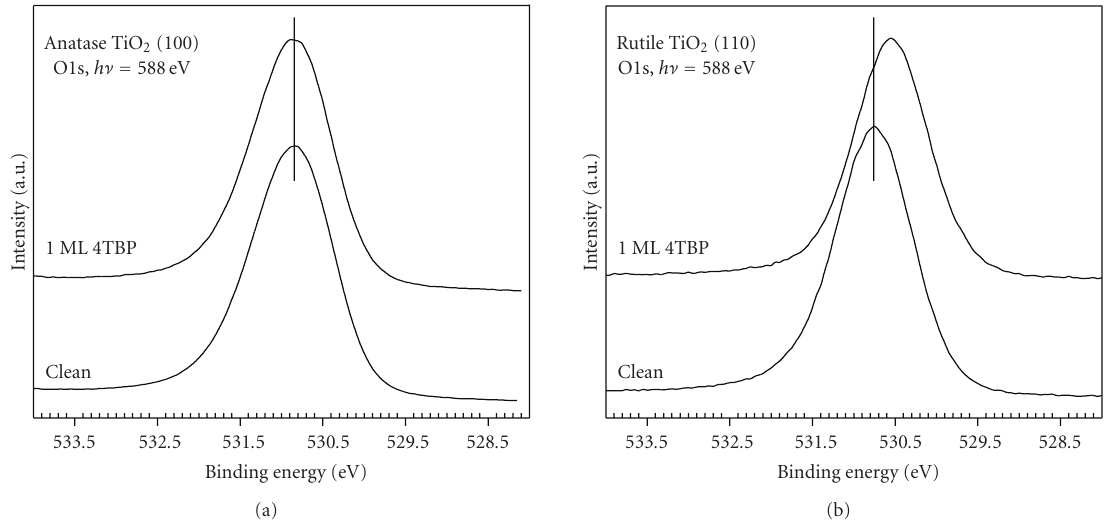
Figure 2: O1s spectra from clean and 4TP covered TiO 2 (100) and TiO 2 (110) surfaces. The photon energy was